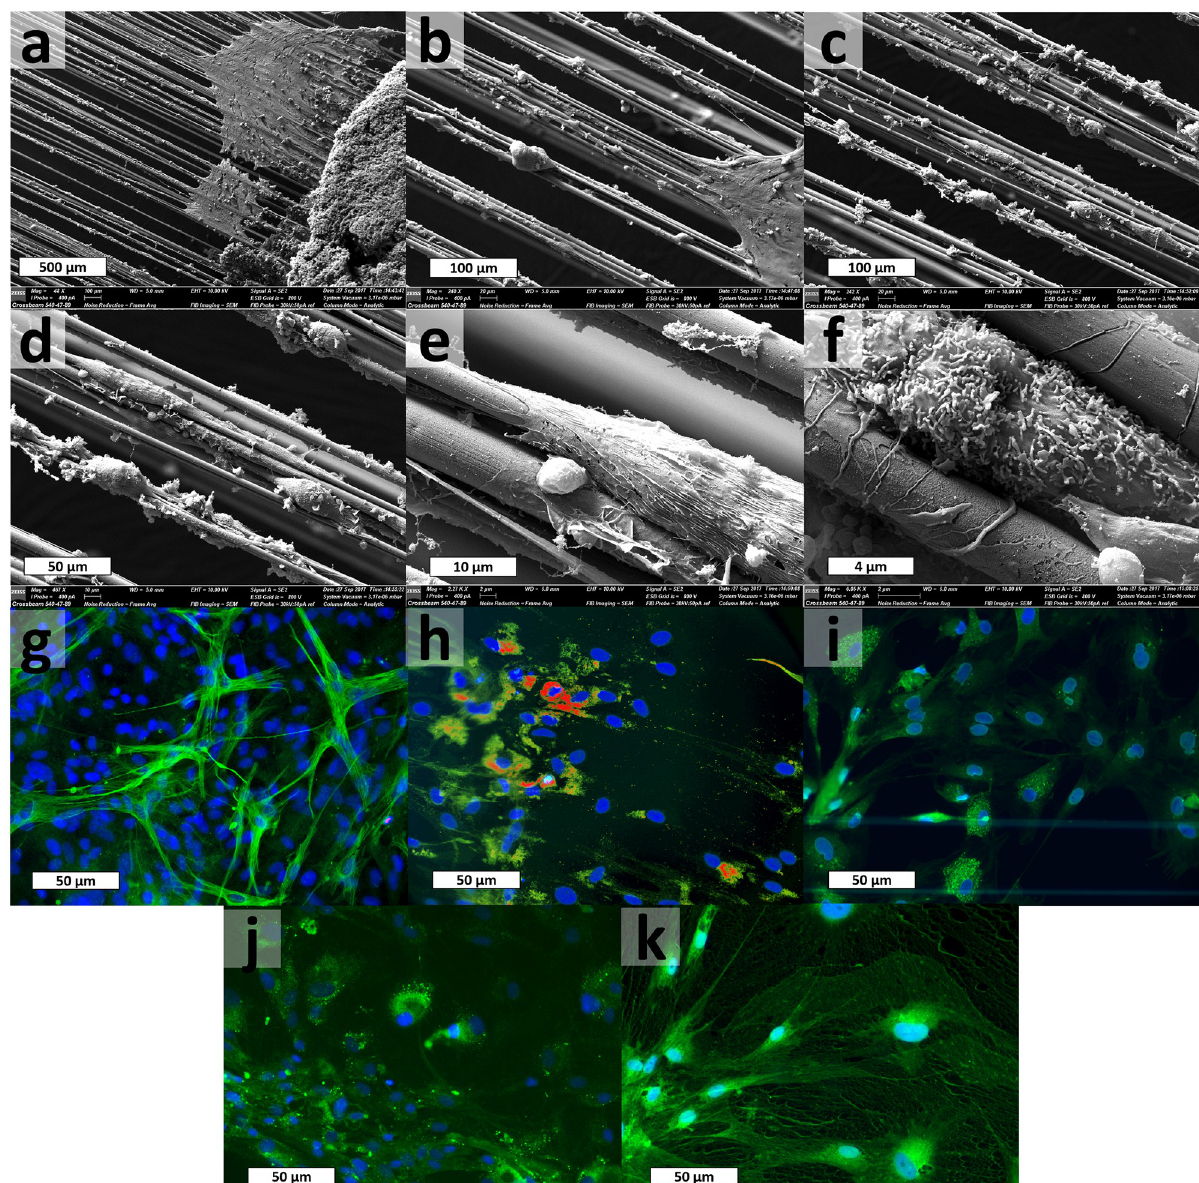
Fig 3. In-vitro examination of spinal cord tissue on spider silk. A-f Scanning electron microscopy of spinal cord tissue explant on spider silk after 21 days of cultivation. The tissue explant can be seen on the right site of a. Cells using the spider silk as guidance are documented in several magnifications. G-k Immuno-fluorescence staining of spinal cord tissue explant on spider silk after 21 days of cultivation. G Neuron-specific class III beta-tubulin (Tuj- 1) indicating neuronal cell bodies and axons (green). H Nestin, intermediate filament protein, as a marker for neural stem cells (red). I CX3C chemokine receptor 1 (CX3CR1) indicating microglial-cells (green). J Myelin basic protein (MBP) indicating oligodendrocytes (green). K Glial fibrillary acidic protein (GFAP), intermediate filament protein indicating astrocytes and ependymal cells (green). Nuclei were counterstained with DAPI and are blue in all